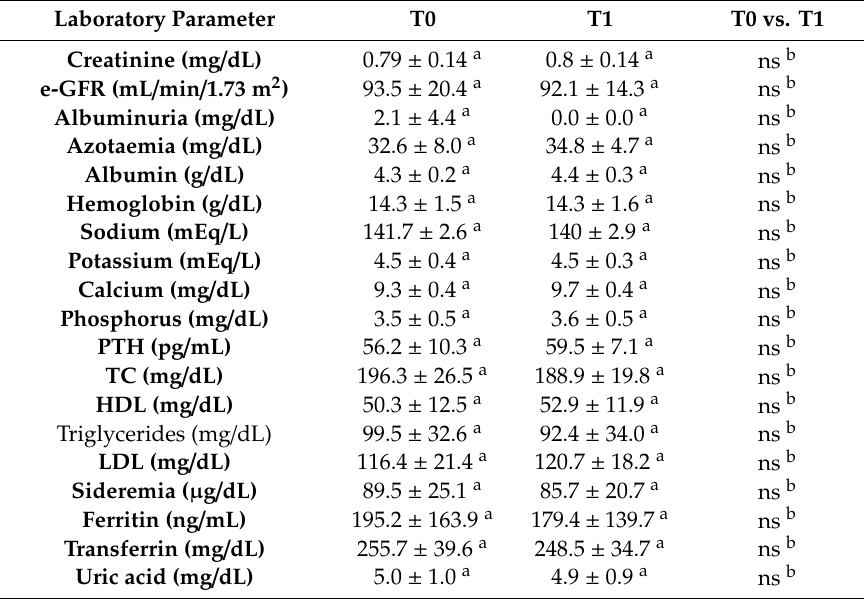
Table 3. Routine laboratory parameters of healthy subjects.